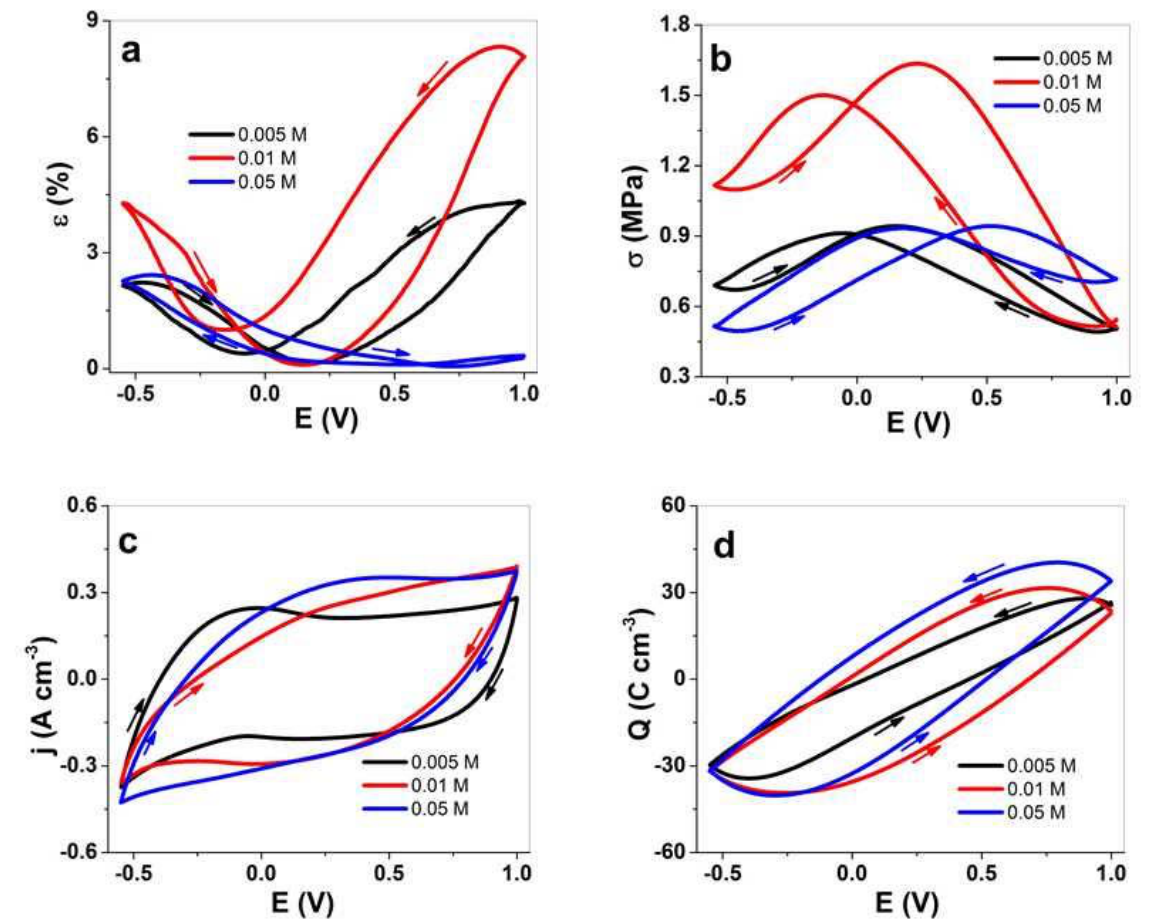
Figure 4. Cyclic voltammetry (scan rate 5 mV s − 1 , 3rd cycle) of PPy/DBS-PT films with PTA concentrations of 0.005 M (black line), 0.01 M (red line), and 0.05 M (blue line) in the TBAPF 6 -PC electrolyte. The strain, ε , is shown in ( a ), the stress, σ , in ( b ), the current density, j, in ( c ), and the charge density, Q, in ( d ) against the potential, E (1.0 to − 0.55 V). The arrows show the direction of the scans.